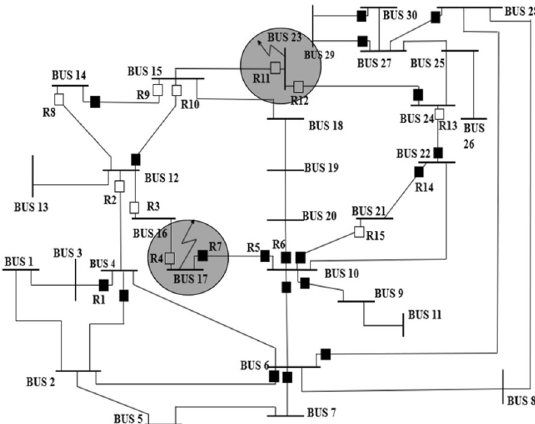
Fig. 10 IEEE 30-bus system under multiple fault